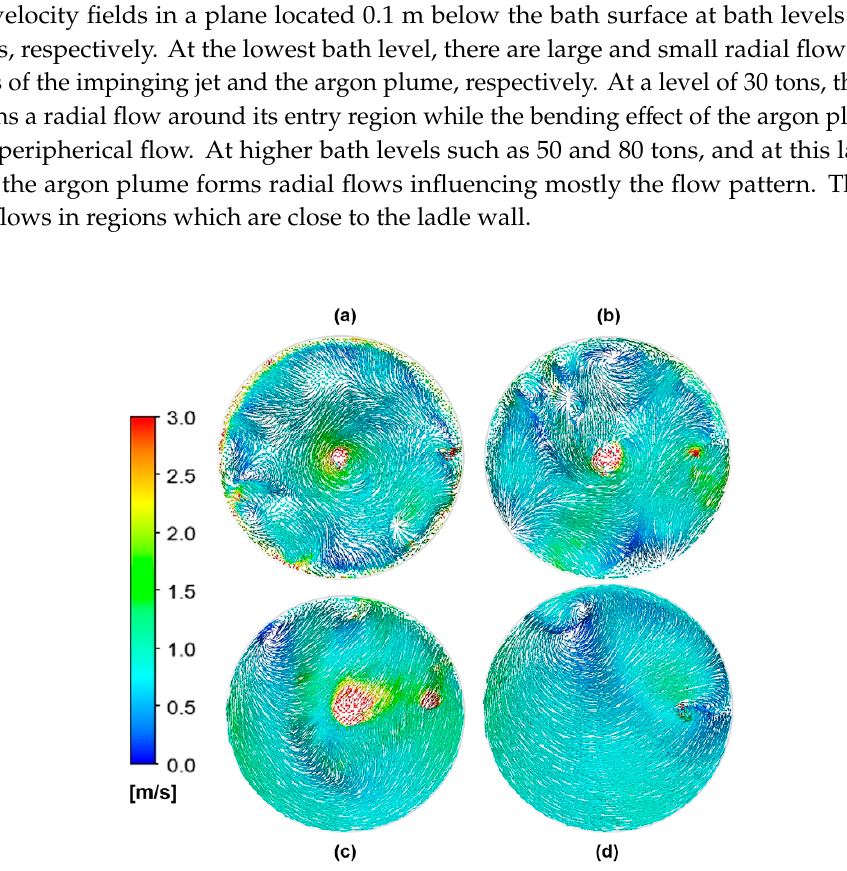
Figure 13. Velocity fields in a horizontal plane located 0.20 m from the ladle bottom at different bath levels: ( a ) 16 tons, ( b ) 30 tons, ( c ) 50 tons and ( d ) 80 tons.